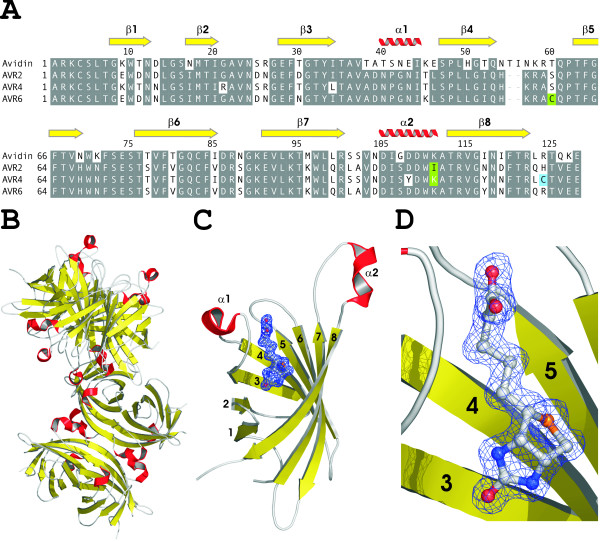
The X-ray structure of AVR2. (A) Multiple sequence alignment of the avidin family. The secondary structure elements are numbered according to the AVR2 structure. The residues mutated in this study (AVR2, Ile-109; AVR4, Lys-109; AVR6, Cys-58) are coloured green. Residue Cys-122 in AVR4, which was mutated to serine in a previous study [36], is indicated in blue. (B) Two tetramers found in the asymmetric unit of the AVR2-b crystal. (C) Monomer A of AVR2-b. The weighted difference Fo – Fc electron density map (blue), calculated in the absence of biotin, is drawn with a 1.5 Å radius around the atoms of D-biotin of the final structure of AVR2-b. Contours are shown at 3.0σ. The secondary structure elements of AVR2-b are numbered. (D) A close-up view of (C) focused on biotin.